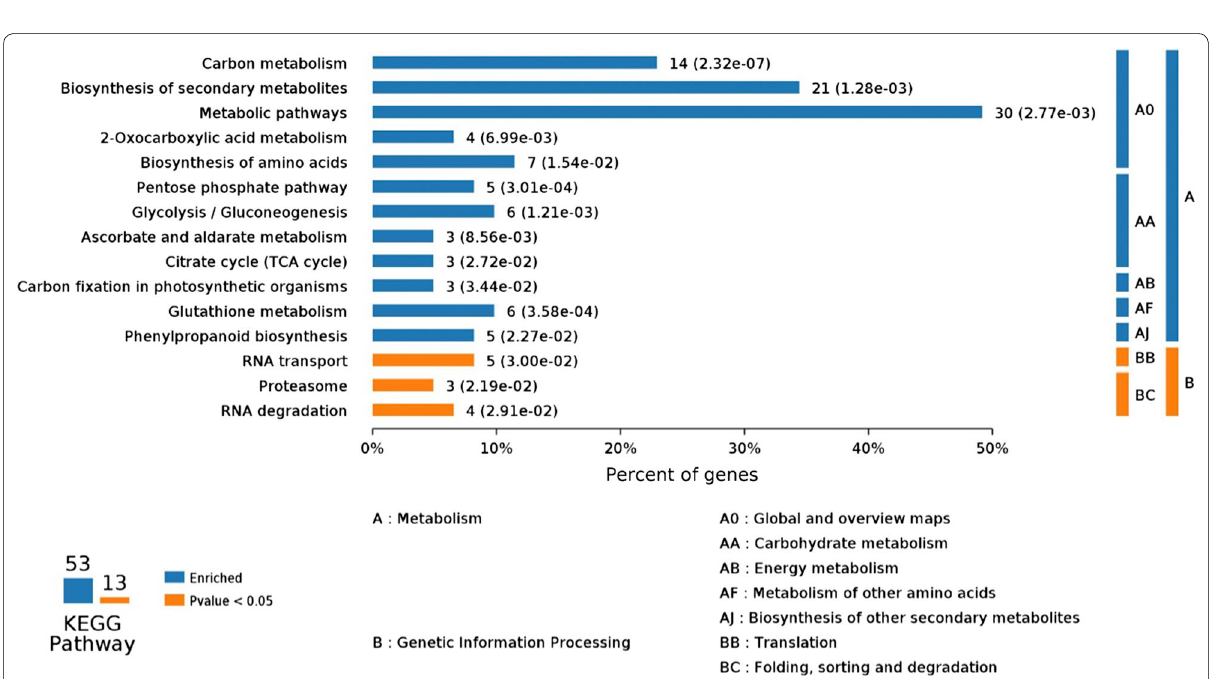
Fig. 6 Compared treatment (B-CK) with the control (A-CK), the differentially expressed proteins KEGG pathway enrichment. The number of involved proteins in a specific pathway and corresponding p value are shown on the right side of